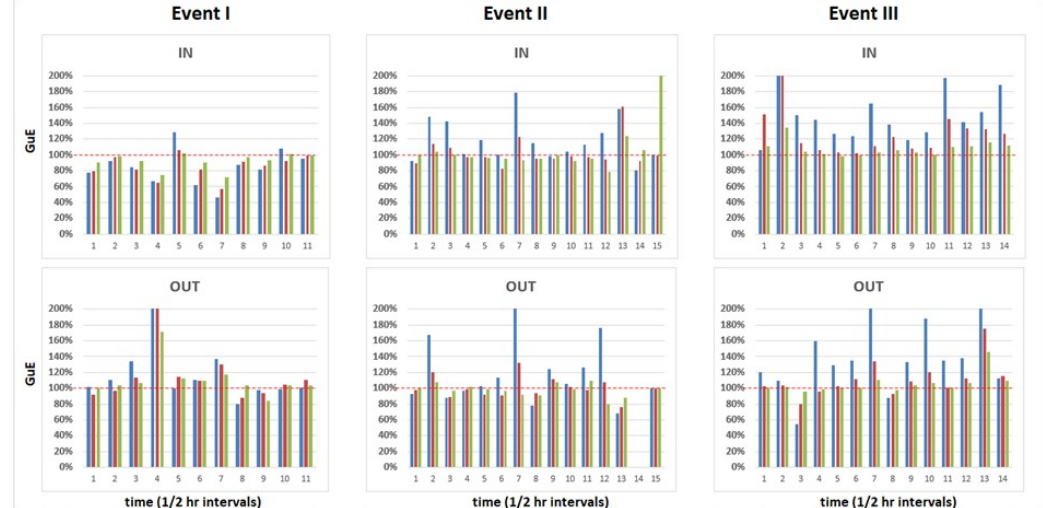
Figure 9. GuE for the three wind events at “IN” and “OUT” in 30 min temporal resolution for PM 10 (blue), PM 2.5 (red), and PM 1 (green). The y ‐ axis was limited to 200% for visibility purposes, resulting